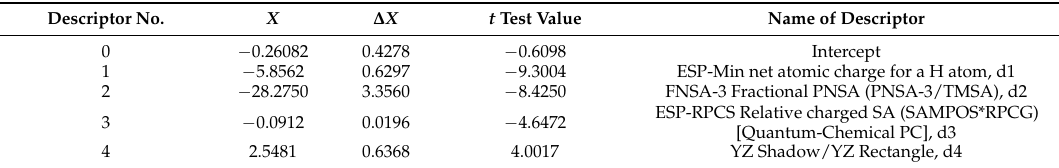
Table 3. Multilinear QSAR model obtained for cinnamaldehyde analogues for Trametes versicolor ( R 2 = 0.910, F = 35.32, and s 2 = 0.0093). Descriptor